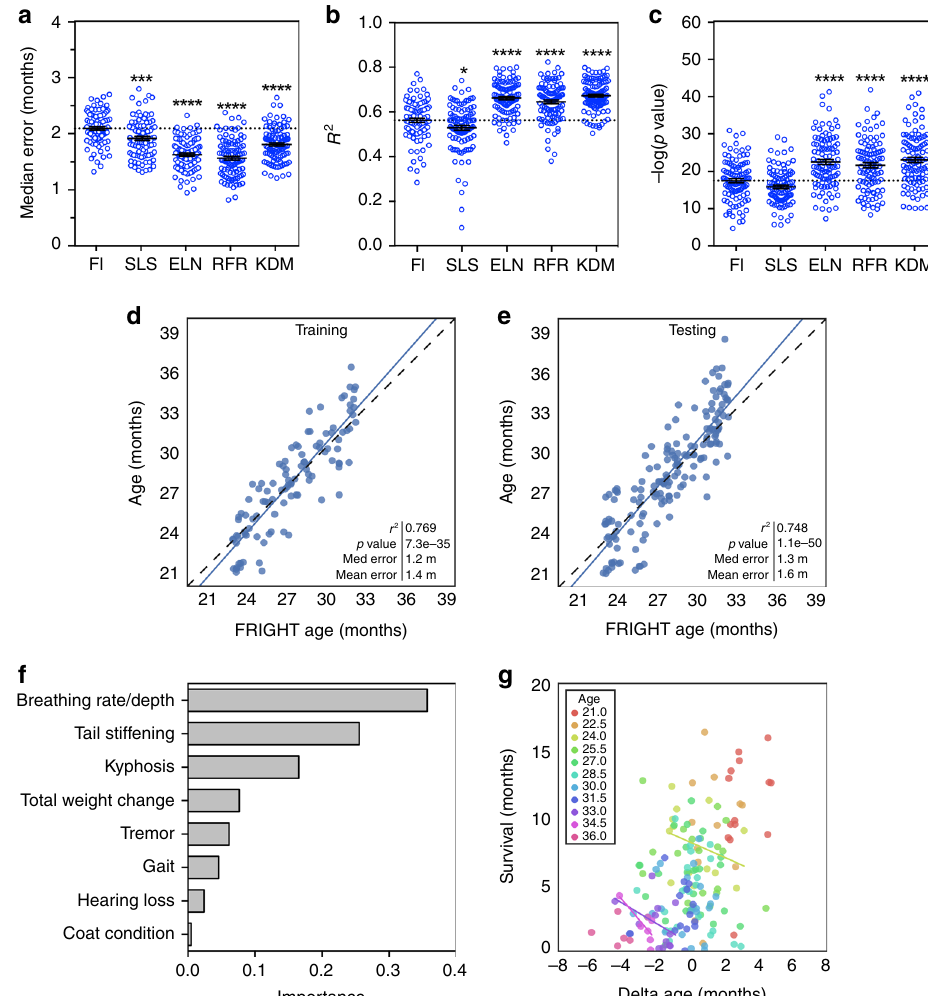
Fig. 3 Multivariate regressions of individual FI items to predict age (FRIGHT age). a – c Median error, r 2 values and p values for univariate regression of Frailty Index (FI) score, and multivariate regressions of the individual FI items using either simple least squares (SLS), elastic net (ELN), the Klemera – Doubal method (KDM), or random forest regression (RFR) for chronological age in the mouse training set. All models were tested with bootstrapping with replacement repeated 100 times, and each bootstrapping incidence is plotted as a separate point. **** p < 0.0001 and *** p < 0.001 compared to FI model with one-way ANOVA. Error bars represent standard error of the mean. d , e Random forest regression of the individual FI items